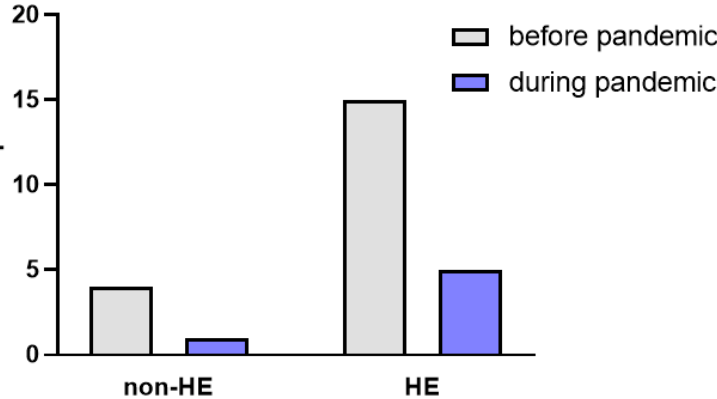
Figure 22. Comparison of the prevalence of skin infections in both groups (non-derm and HE-derm) before and during the pandemic. There was a significant decrease in the frequency of hand skin infections before and during the pandemic between: the HE-derm group before and the HE-derm group during the pandemic, and the HE group before the pandemic and the HE group during the pan- demic ( p < 0.05, p < 0.05, respectively) (Figure 23).